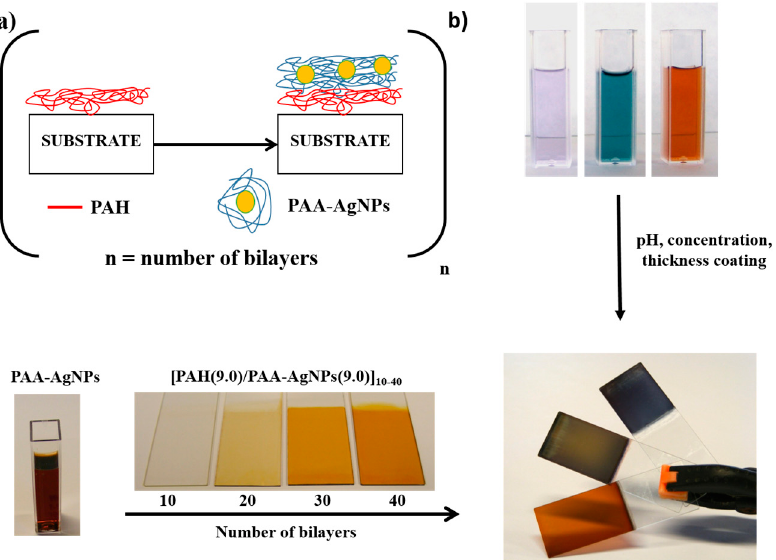
Figure 2. ( a ) Schematic representation of the layer-by-layer (LbL) technique by using poly(allylaminehydrochloride) (PAH) as a polycation and poly(acrylic acid, sodium salt) (PAA) as a polyanion which is acting as a capping agent of the silver nanoparticles (PAA-AgNPs) and aspect of the orange colored LbL coatings as a function of the number of bilayers. ( b ) Multicolored LbL coatings (orange, green or violet) as a function of previous synthesized PAA-AgNPs and the pH, concentration and thickness coating. Reproduced from [19] with permission; Copyright Springer 2013.